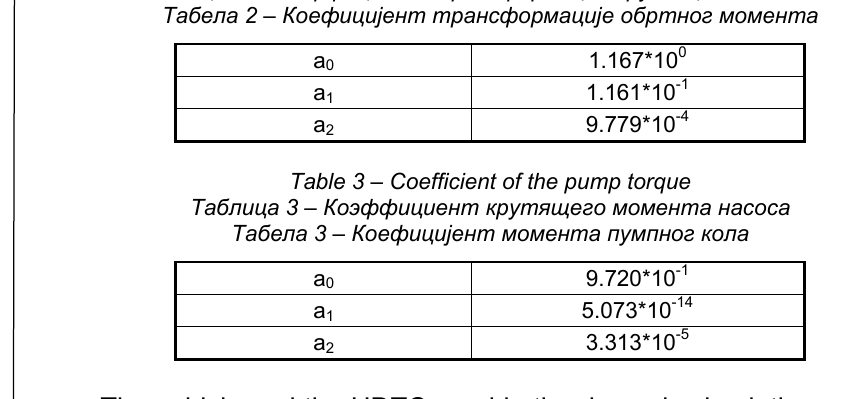
Table 2 – Torque Transformation Coefficient